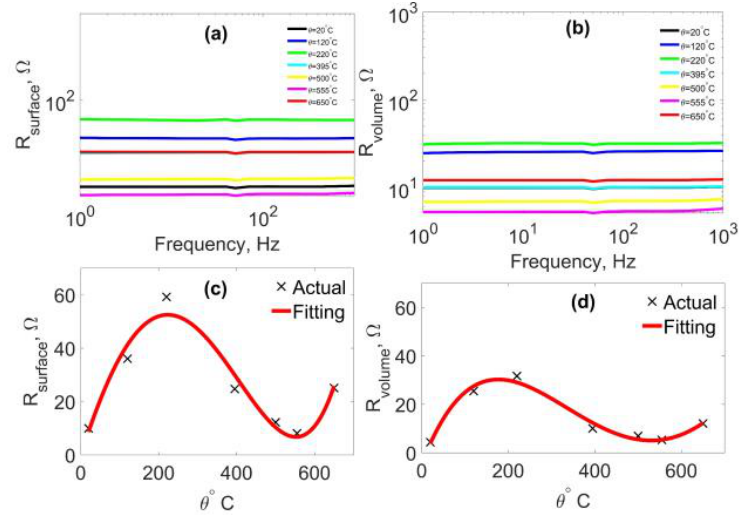
Figure 9. Temperature-dependent surface and volume parametric resistance of the char material measured under higher temperature. ( a ) Actual values of surface resistance; ( b ) actual values of volumetric resistance; ( c ) temperature dependency of the surface resistance; ( d ) temperature dependency of the volumetric resistance.